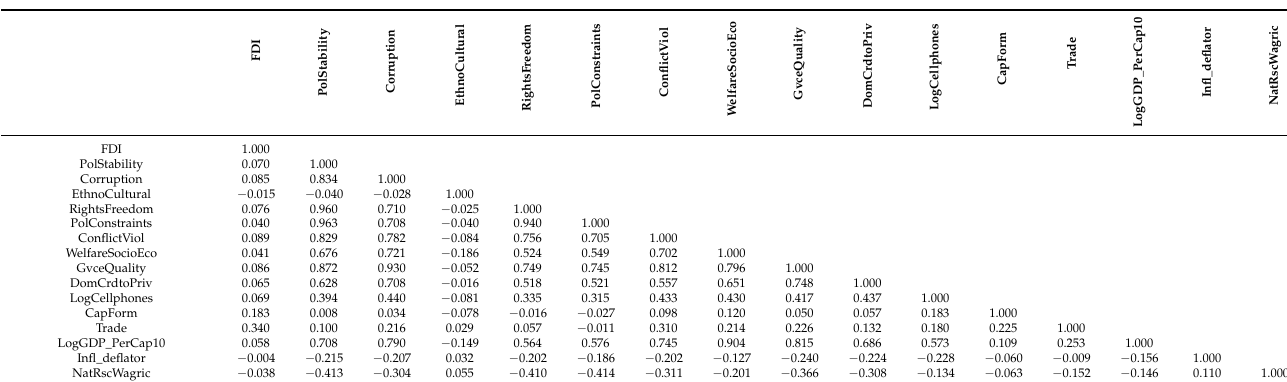
Table 2. Correlation